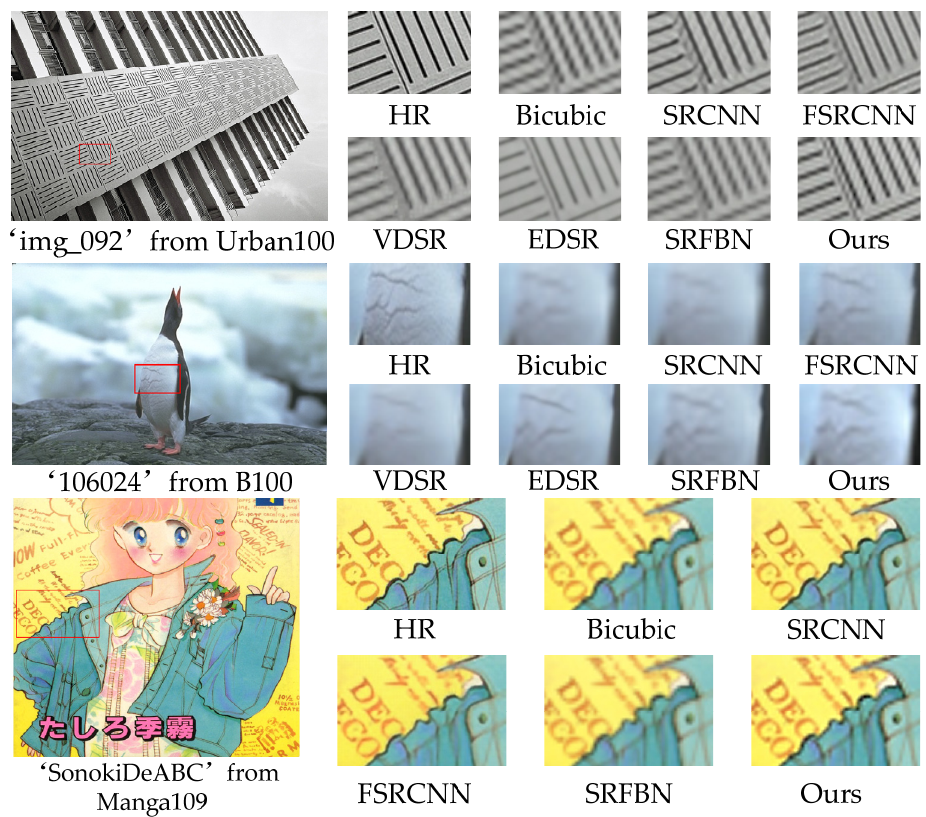
Figure 10. Visual comparison on the Urban100, B100, and Manga109 datasets for 4× SR.